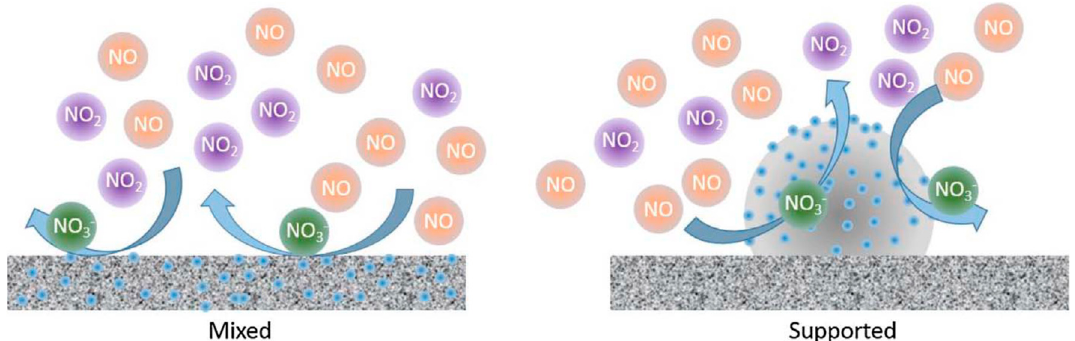
Figure 43. Conventional mortar/concrete with the photocatalyst embedded within the aggregate (mixed), and aggregate-supported configuration of the photocatalyst (blue) applications in proposed concrete technology whereby the photocatalyst is supported on sort of binder that bonds both the photocatalyst and the cementitious support. Reproduced with permission from Yang et al. [132]. Copyright 2018 by The Authors (open access license).